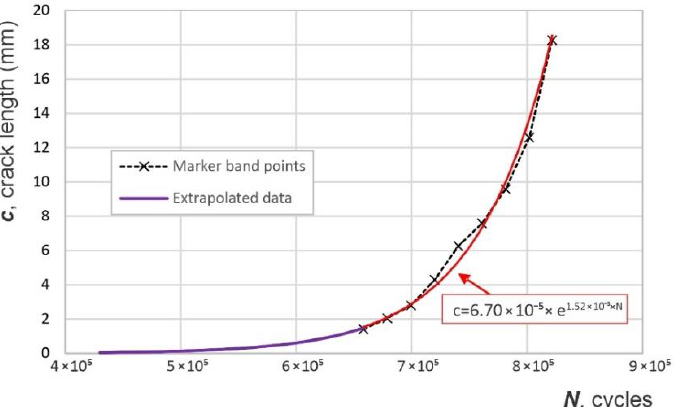
Figure 4. Crack growth measured using marker bands; crack length, c, as a function of number of cycles, N. cycles,